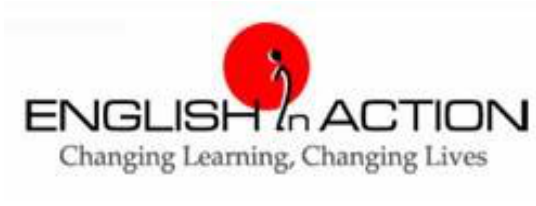
Figure 5 English in Action’s (EIA) logo and slogan EIA’s School-based Professional Development (SBPD)